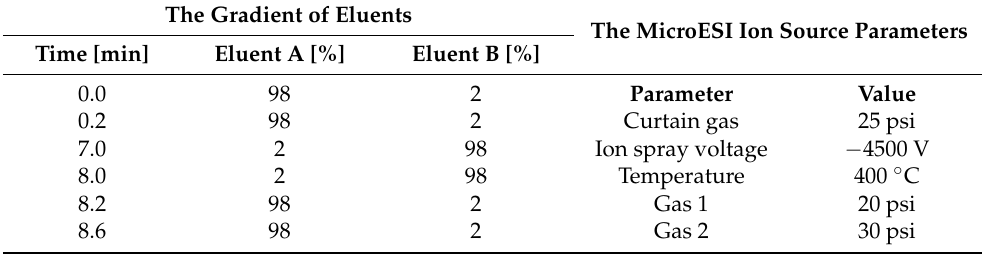
Table 3. Eluent gradient and the parameters of the ion source used during LC-MS/MS